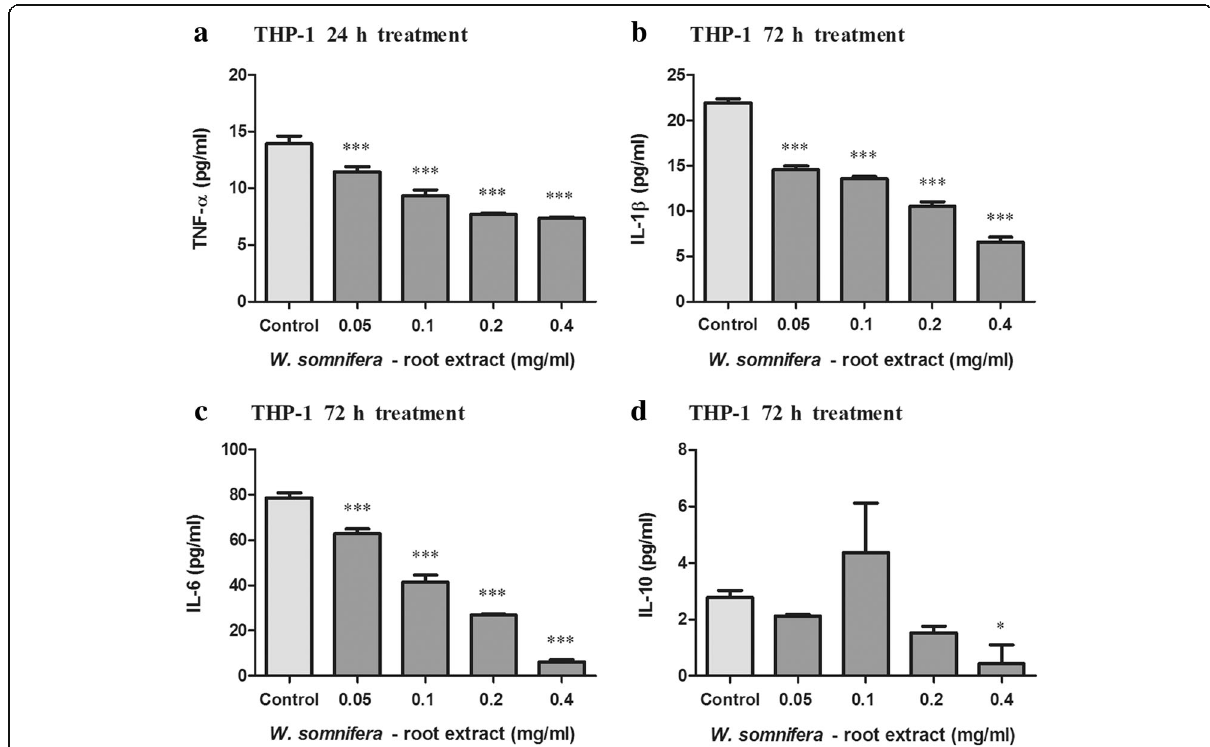
Fig. 4 Concentration of TNF- α ( a ), IL-1 β ( b ), IL-6 ( c ) and IL-10 ( d ) in LPS stimulated and W RE treated THP-1 cells (Values expressed as mean ± SD, * p < 0.05, *** p < 0.0001 compared to the